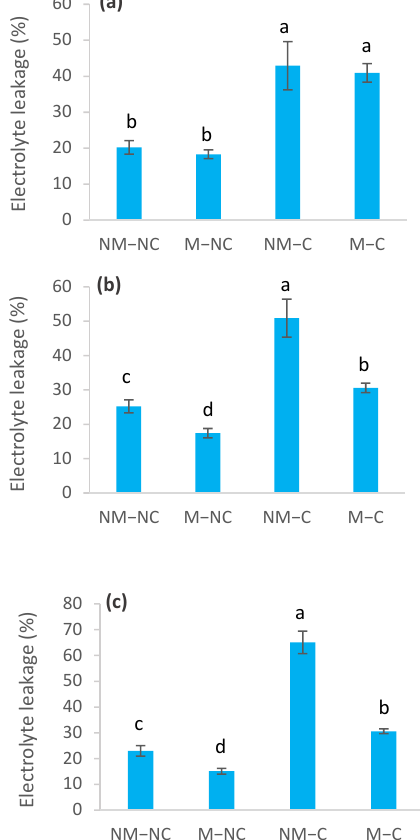
Figure 5. Electrolyte leakage of ectomycorrhizal (M) and non-ectomycorrhizal (NM) Pinus halepensis seedlings after 4 ( a ), 8 ( b ) and 12 months ( c ) of growth in contaminated (C) and control soil (NC). Means ( ± SD; n = 4) with different letters significantly differ from one another based on Tukey’s tests at p ≤ 0.05.